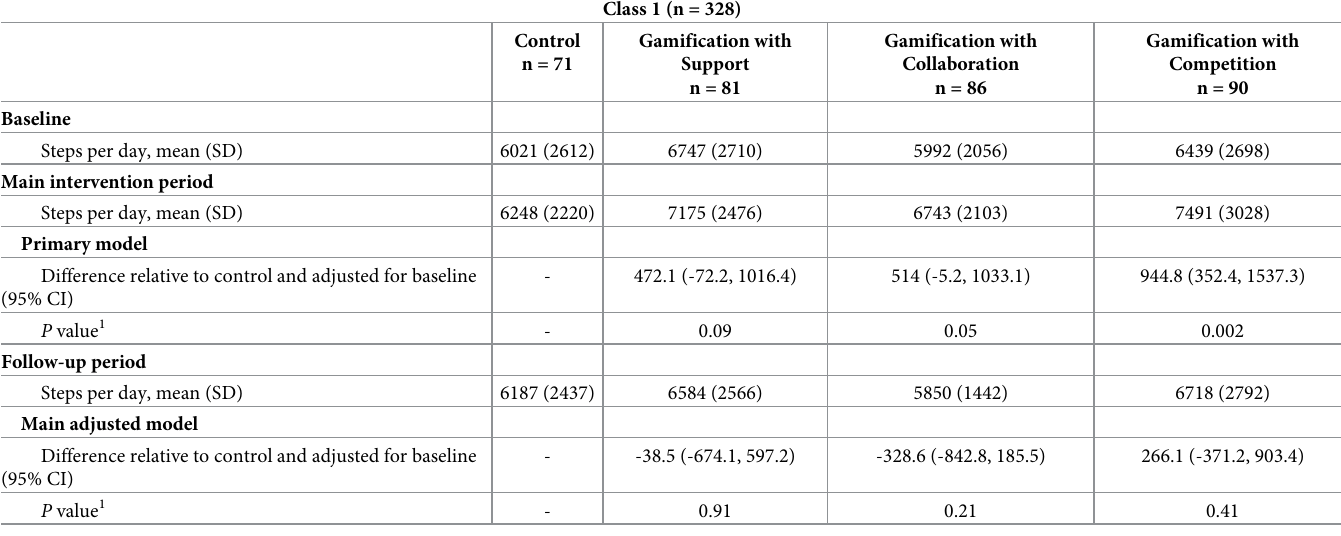
In adjusted analyses, class 1 participants had a significant change in mean daily step counts during the intervention period for only the gamification with competition arm (adjusted dif- ferences relative to control, 945 steps; 95% CI, 352–1537; P = .002) (Table 3). However, there was no significant change in mean daily steps relative to control for any of the gamification arms during follow-up. Table 3. Adjusted model of change in mean daily step count by intervention arm for class 1 (extroverted and